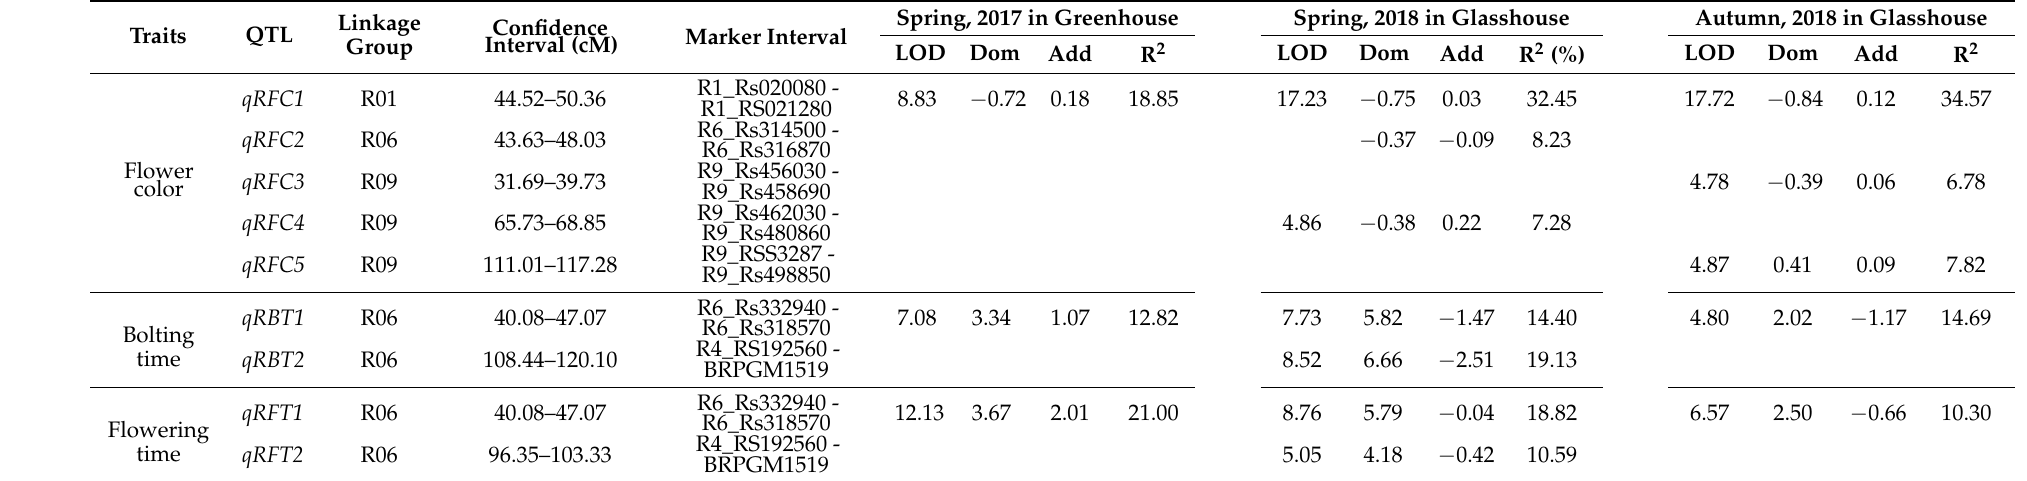
Table 2. Details regarding the QTLs identified for radish flower color, bolting, and flowering time